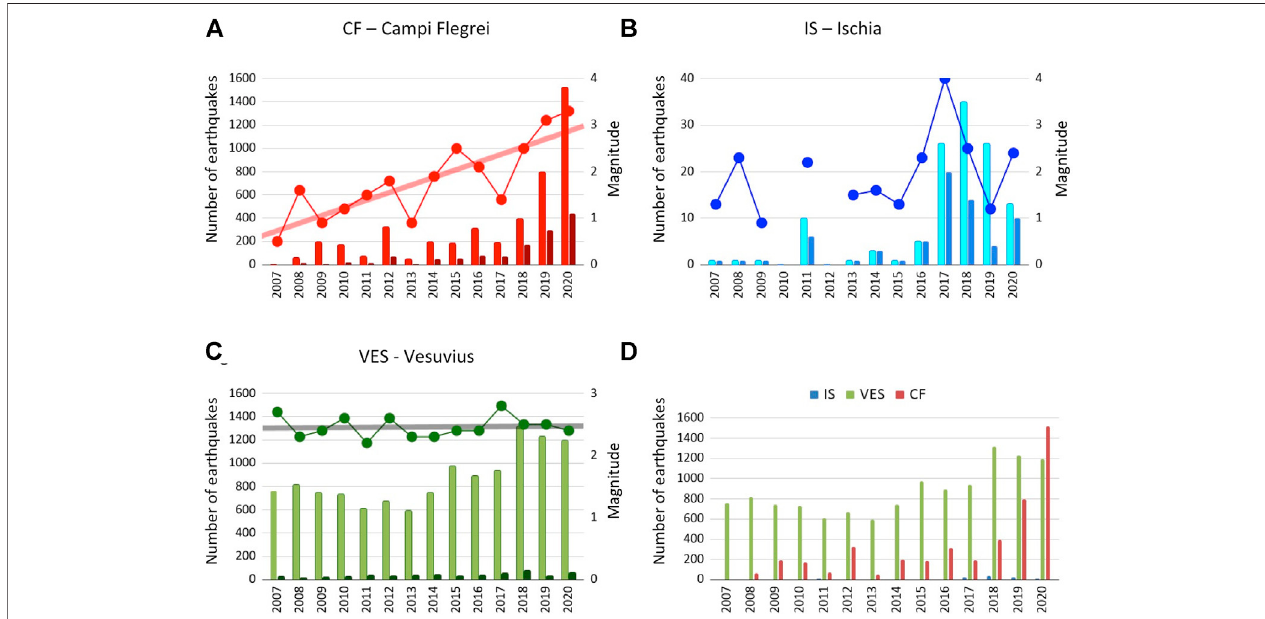
FIGURE 12 | Comparison of the seismicity of the three Neapolitan volcanoes in the period 2007 – 2020. (A) Histogram of occurrence of earthquakes in Campi Flegrei(alldetectedeventsinredandearthquakesofM > (cid:1) Mcindarkred)andmaximummagnitude(redcurve). (B) HistogramofoccurrenceofearthquakesinIschia(all detectedeventsincyanandearthquakesofM > (cid:1) Mcinblue)andmaximummagnitude(bluecurve). (C) HistogramofoccurrenceofearthquakesinVesuvius(alldetected events in green and earthquakes with M > (cid:1) Mc in dark green. For the latter the values on the y axis are multiplied by 2) and maximum magnitude (green curve). Linear trend lines are reported for the maximum magnitude curve in the three volcanoes. (D) Histogram summarizing the occurrence of earthquakes in the three volcanoes. IS (cid:1) Ischia; Ves (cid:1) Vesuvius; CF (cid:1) Campi Flegrei.